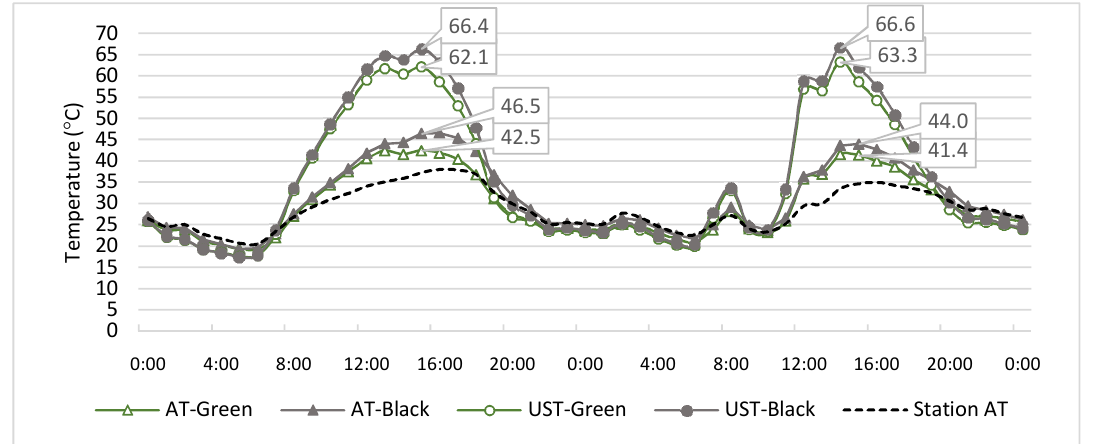
Figure 11. Energy production performance of EP-Green vs. EP-Black (19–20 July).